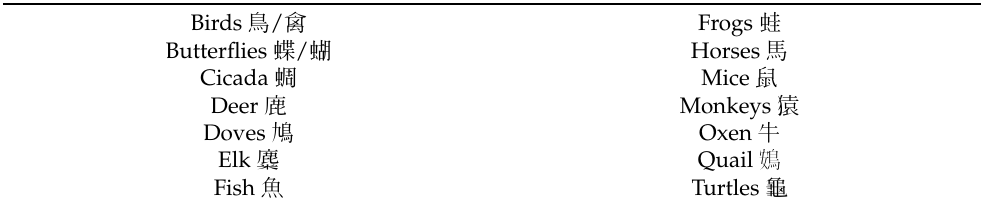
Table 2. Classical Daoist Zoology. Birds 鳥 / 禽 Frogs 蛙 Butterflies 蝶 / 蝴 Horses 馬 Cicada 蜩 Mice 鼠 Deer 鹿 Monkeys 猿 Doves 鳩 Oxen 牛 Elk 麋 Quail 鴳 Fish 魚 Turtles